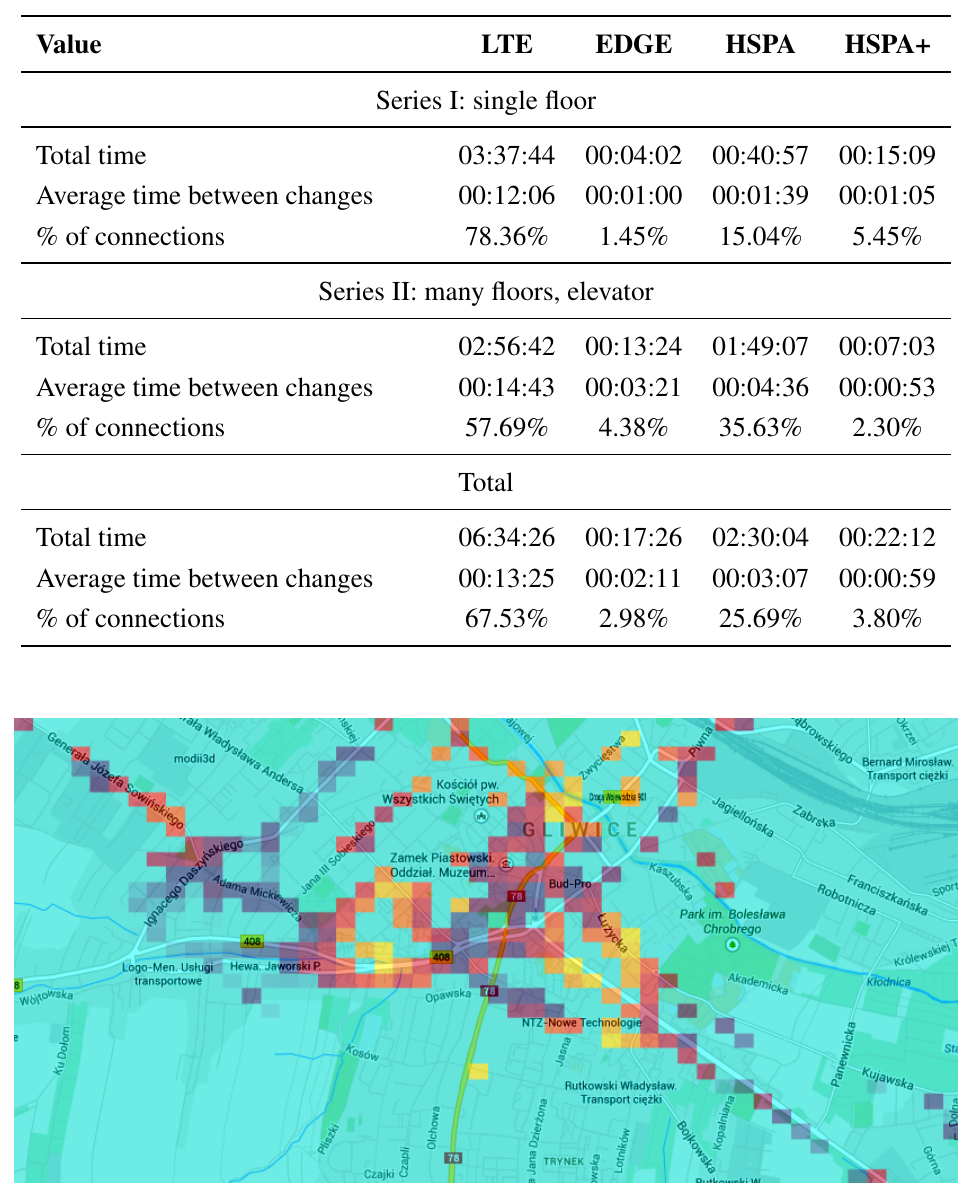
Table 6. Dependence of connection technology on the movement pattern (Experiment 4).